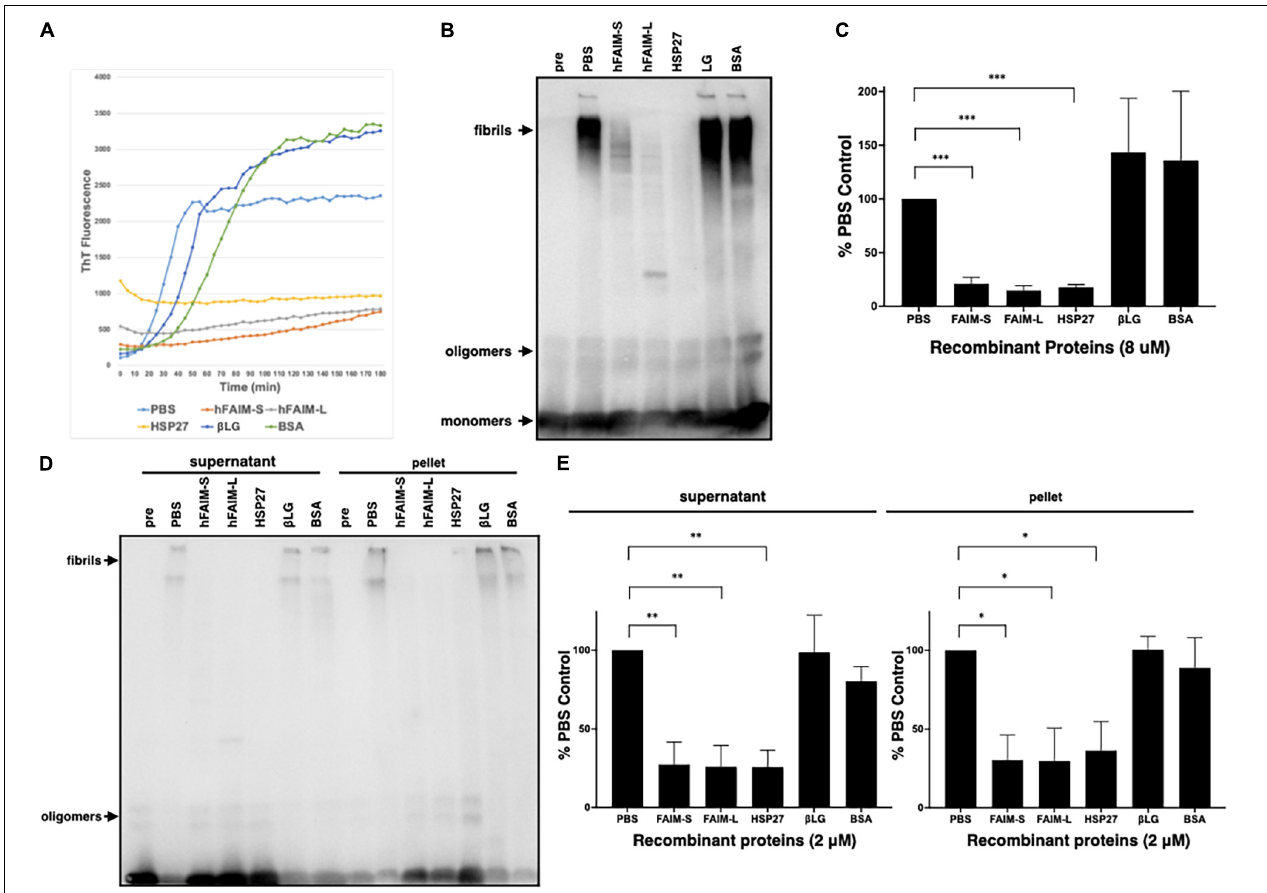
FIGURE 3 | Recombinant FAIM suppresses protein fibrillization/aggregation in a cell-free system. (A) Spontaneous fibrillization of A β (5 µ M) in vitro was monitored by ThT assay over a period of 2 h in the presence of 2 µ M recombinant FAIM-S, FAIM-L, HSP27, β LG or BSA. ThT fluorescence was recorded every 5 min. (B) Total samples after the same reaction without ThT were subjected to SDS-PAGE and western blotted for A β . (C) The densitometry of fibrils in (B) from 3 independent experiments are shown as percent of PBS control. The data are expressed as mean ± SEM. (D) Protein samples after the same reaction without ThT were centrifuged at 14,000 × g for 10 min. Both supernatant and pellet fractions were subjected to SDS-PAGE and western blotted for A β . Representative data from at least three independent experiments are shown. (E) The densitometry of fibrils in (D) from three independent experiments are shown as percent of PBS control. The data are expressed as mean ± SEM. (C,E) A two-tailed, unpaired Student’s t -test was used to calculate p -values. ∗ p < 0.05, ∗∗ p < 0.01 or ∗∗∗ p <